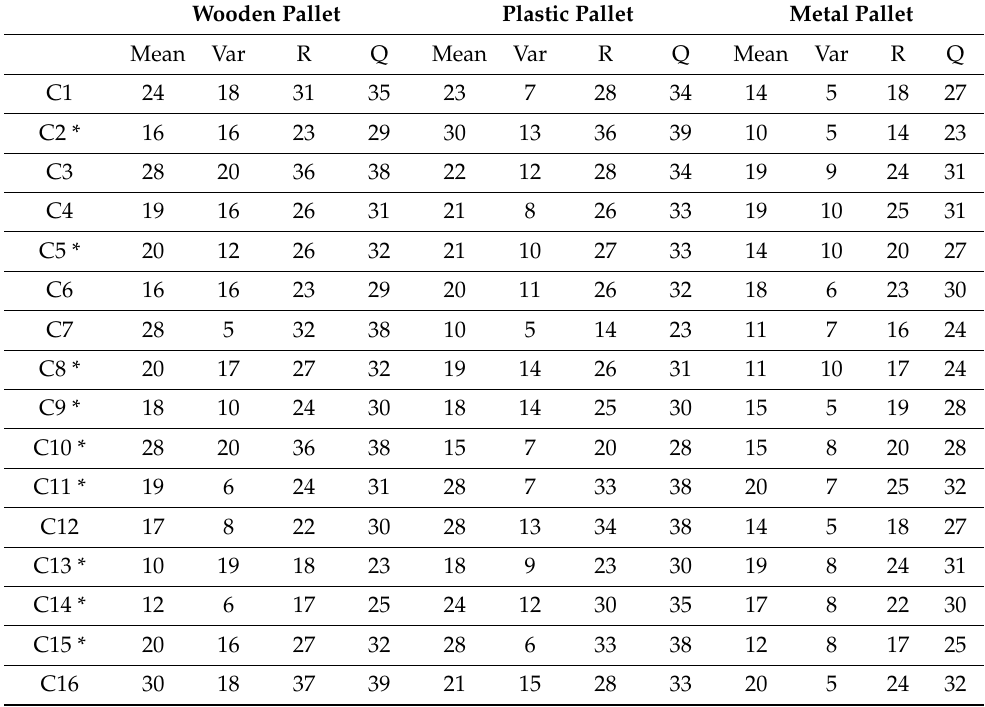
Table 4. Reorder points and quantities for sixteen users in the